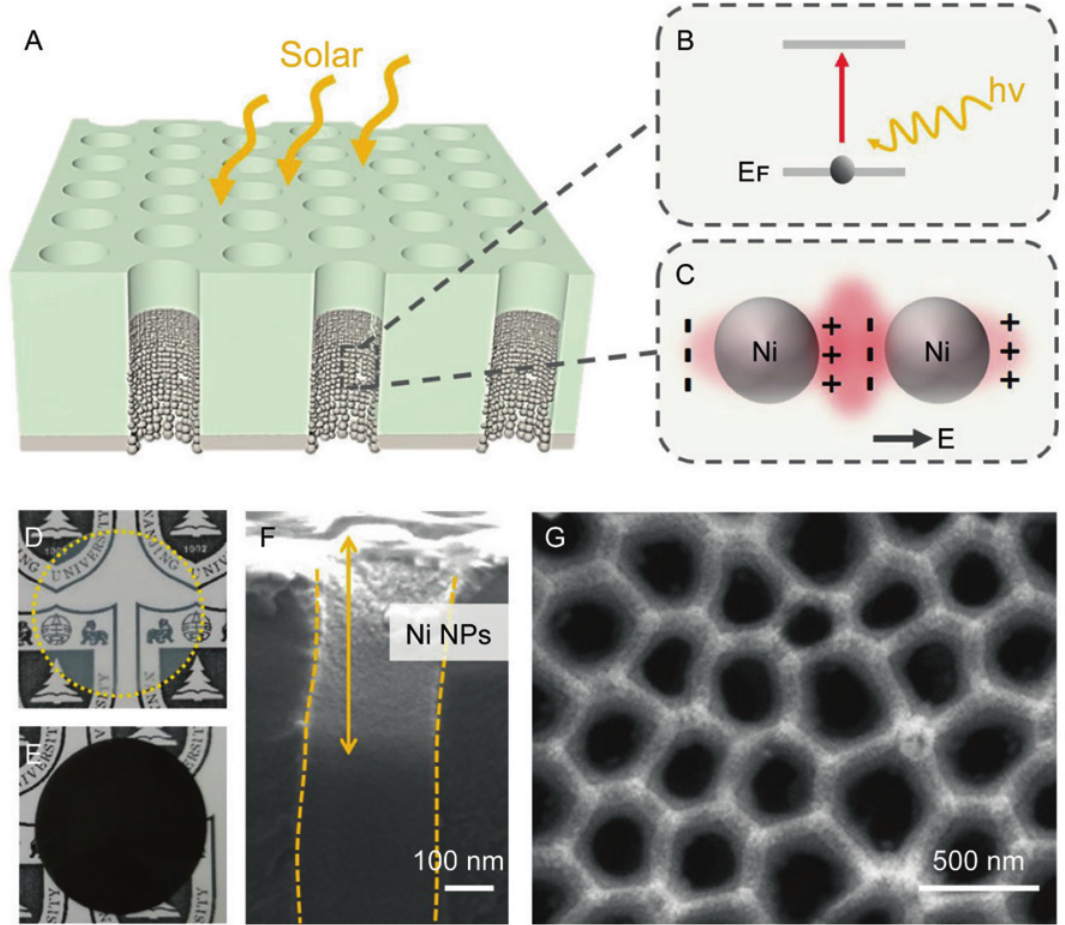
Figure 1: (A) Schematic of Ni nanoparticle absorbers based on porous substrate induced physical self-assembly. (B) Single electron excitation. E F is Fermi level. (C) Collective oscillation of free electrons. E is the electric fi eld. (D-E) Optical images of baer AAO and Ni NPs/AAO before and after the ion sputtering process. (F-G) Cross sectional (F) and bottom (G) view SEM images of the prepared Ni NPs/AAO structure,